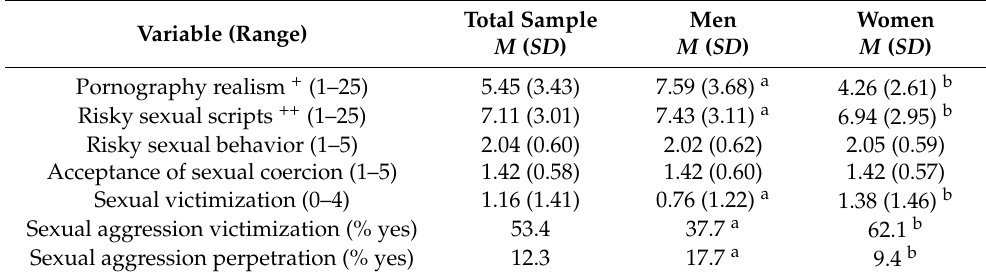
Table 1. Means and standard deviations of all model variables.